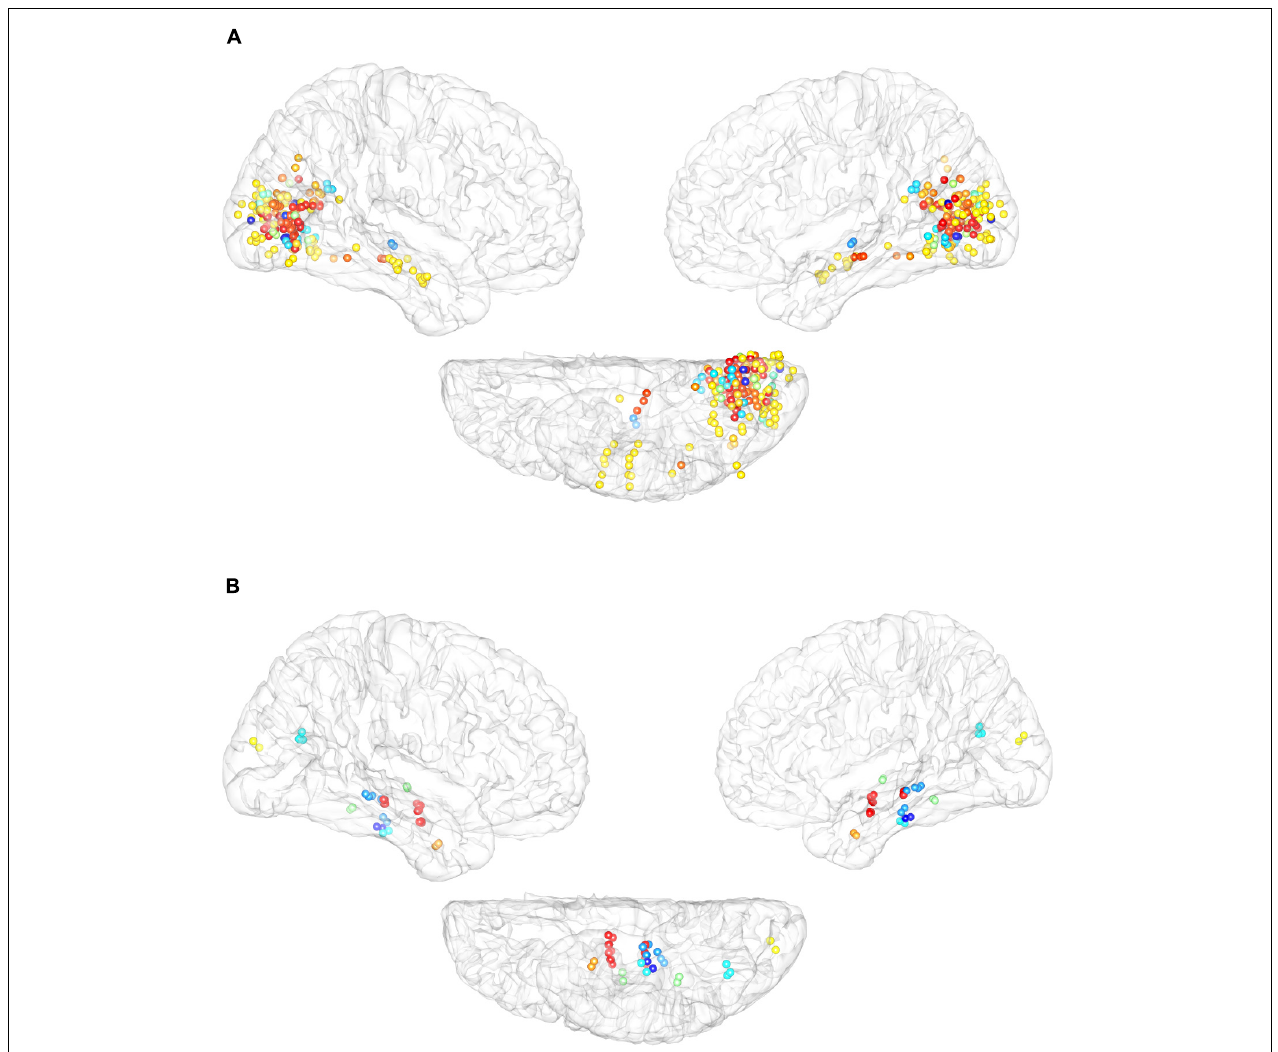
FIGURE 5 | Cross-participant reliability of elicited response to electrical stimulation. (A) Cortical distribution of electrodes that elicited external visual sensation of flickers across different participants. (B) Cortical distribution of electrodes that elicited internal visual sensations by electrical stimulation. Different color-coded dots encode different